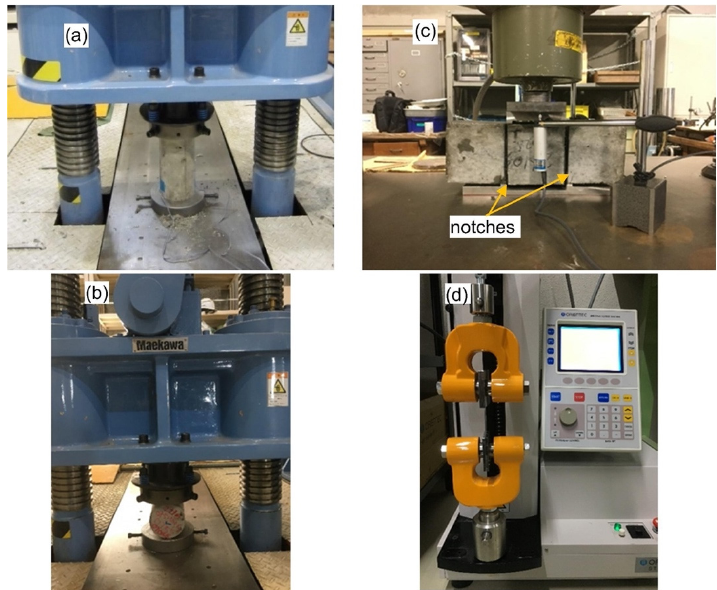
Figure 4. Experimental set-up for measuring ( a ) recycled aggregate concrete (RAC) compressive strength, ( b ) RAC splitting tensile strength, ( c ) RAC shear strength and ( d ) tension strength of recycled fiber. Reprinted with permission from [43]. Copyright©2018, Elsevier B.V.